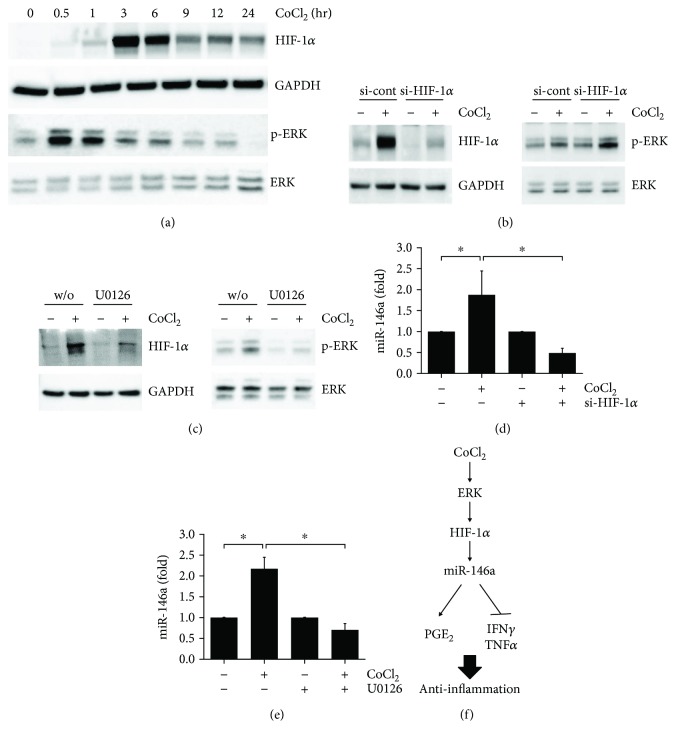
Cobalt chloride (CoCl2) stimulates the immunomodulation of hUCB-MSCs through an ERK- and HIF-1α-dependent pathway. (a) hMSCs were treated with 100 μM CoCl2 and then harvested at the indicated times. The protein level of HIF-1α and p-ERK was determined by Western blot analysis. (b) At 48 hr posttransfection with control siRNA (CTRL) or HIF-1α-specific siRNA (si-HIF-1α), hUCB-MSCs were treated with 100 μM CoCl2 for 30 min or 3 hr. (c) hUCB-MSCs were treated with 100 μM CoCl2 for 30 min or 3 hr in the absence or presence of 10 μM U0126. ERK phosphorylation and HIF-1α expression were determined by Western blot analysis. (d) hUCB-MSCs were transfected with control siRNA (si-control) or HIF-1α siRNA (si-HIF-1α) and then treated with 100 μM CoCl2 for 72 h. (e) hUCB-MSCs were pretreated with the vehicle control (DMSO) or the ERK-specific inhibitor 10 μM U0126 for 60 min and then treated with 100 μM CoCl2 for 72 h. The expression level of miR-146a was determined by RT-qPCR. (f) Schematic illustration of the molecular mechanisms involved in the CoCl2-enhanced anti-inflammatory effects. Data represent the mean ± SD, n = 3; ∗
p < 0.05. P: hPBMCs; P∗: allogeneic hPBMCs as stimulator; H: phytohemagglutinin; MSC: naïve hUCB-MSCs; CoMSC: CoCl2-pretreated hUCB-MSCs.